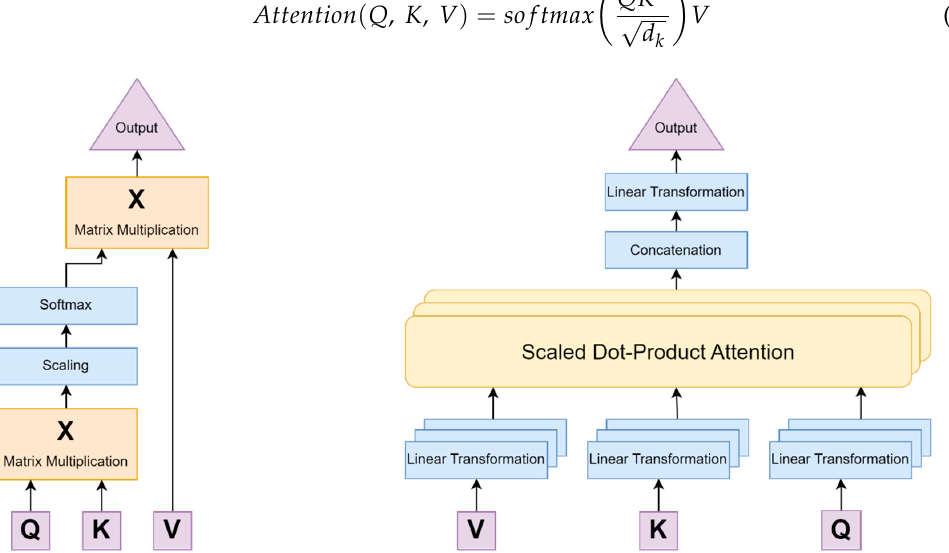
Figure 3. Scaled Dot-Product Attention ( left ) and Multi-Head Attention ( right ) graphical represen- tations.